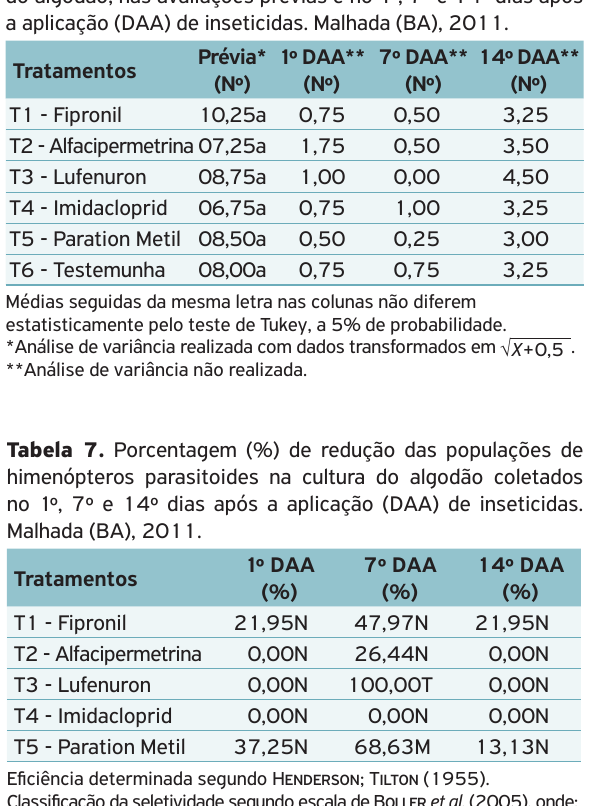
Tabela 6. Número médio de parasitoides coletados na cultura do algodão, nas avaliações prévias e no 1º, 7º e 14º dias após